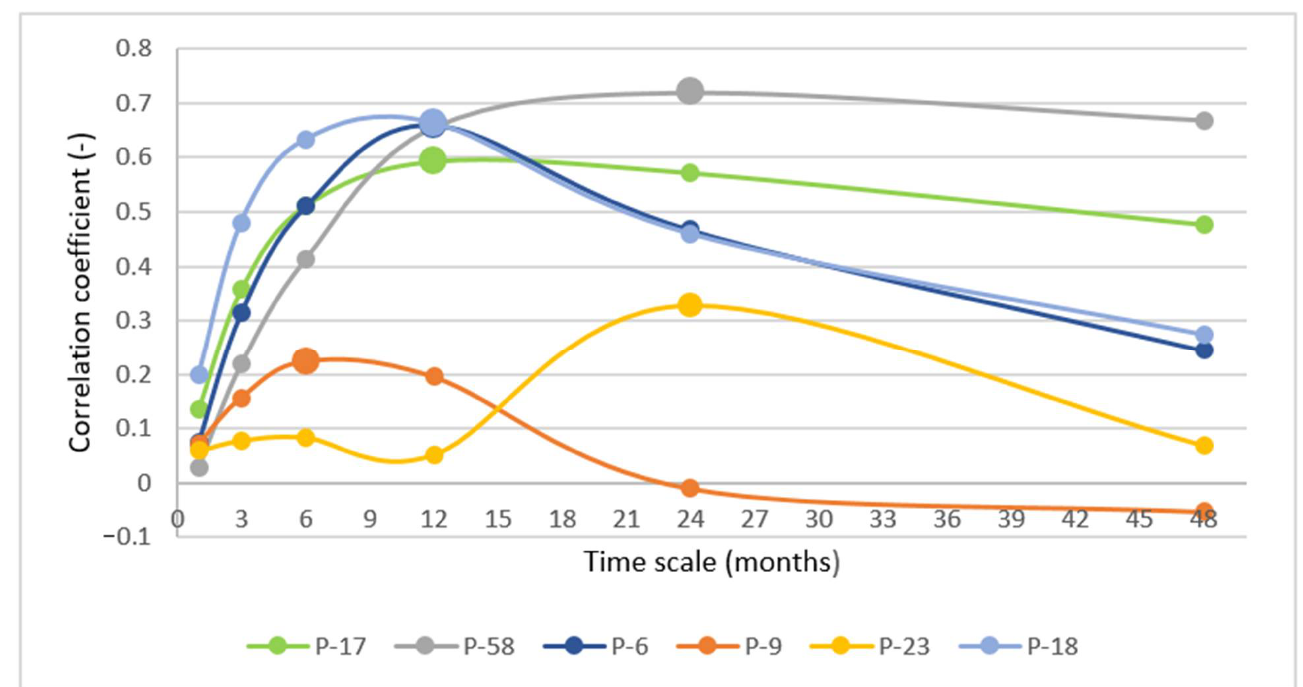
Figure 8. SPI/GW correlation in different time scales for six observation wells.